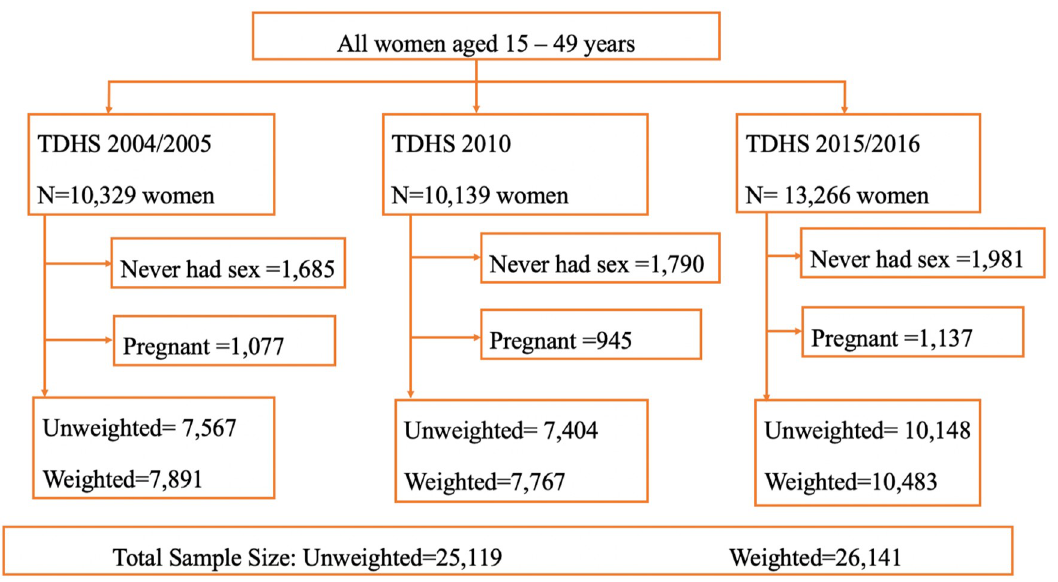
Fig 1. Flow chart for selection of study